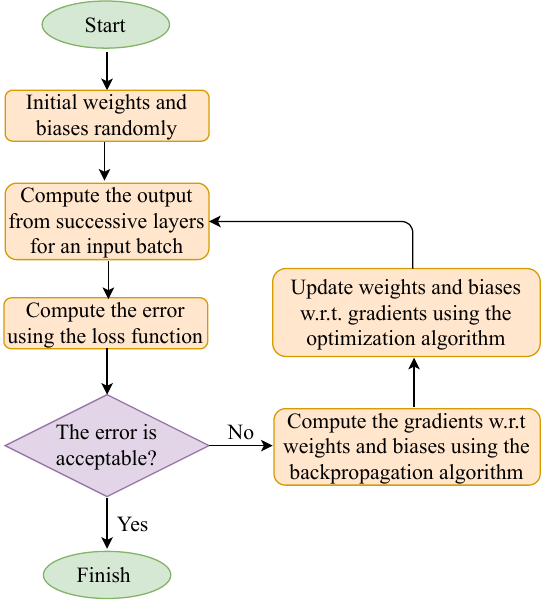
Figure 12. During training, the parameters of the model (weights and biases) are modified using the backpropagation and optimization algorithms to minimize